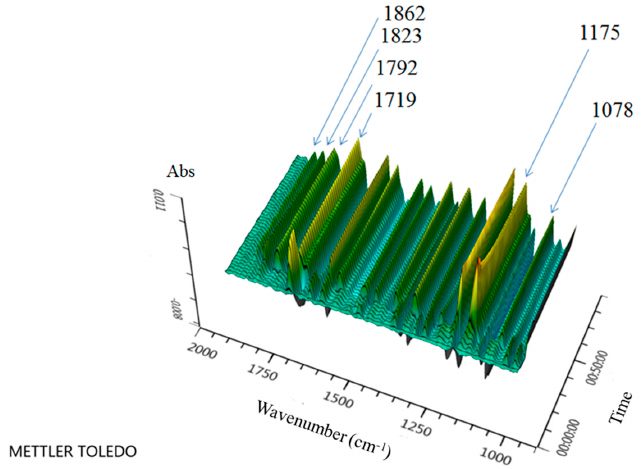
Figure 1. ConcIRT component profiles of oxidative reaction. 1. Added the material; 2. Added the oxidation PhI(OCOCF 3 ) 2 ; 3, 4. Got sample.